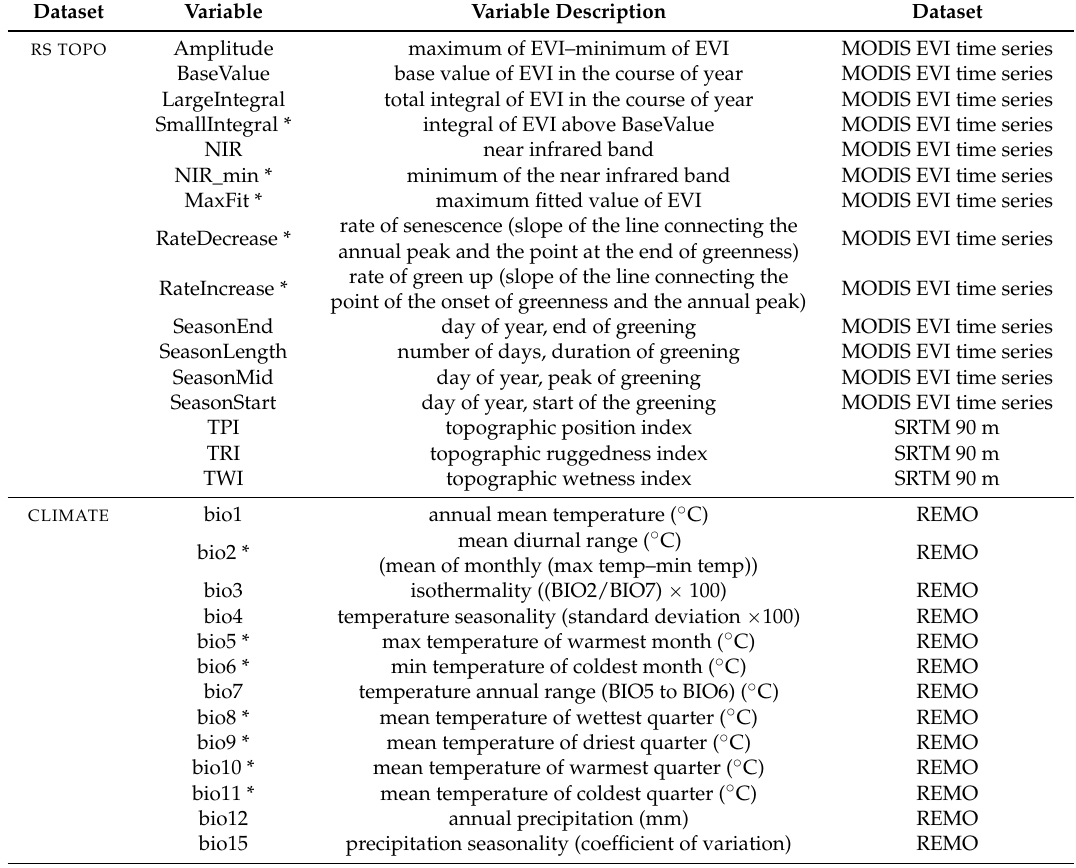
Table 1. Description of predictor variables and data sources. All variables excluded from modelling after screening for collinearity among predictor variables are denoted with an asterisk. SRTM: digital elevation model of shuttle radar topography mission; REMO: regional climate model for the domain of south central Africa forced with the global circulation model ECHAM. RS TOPO , remote sensing and